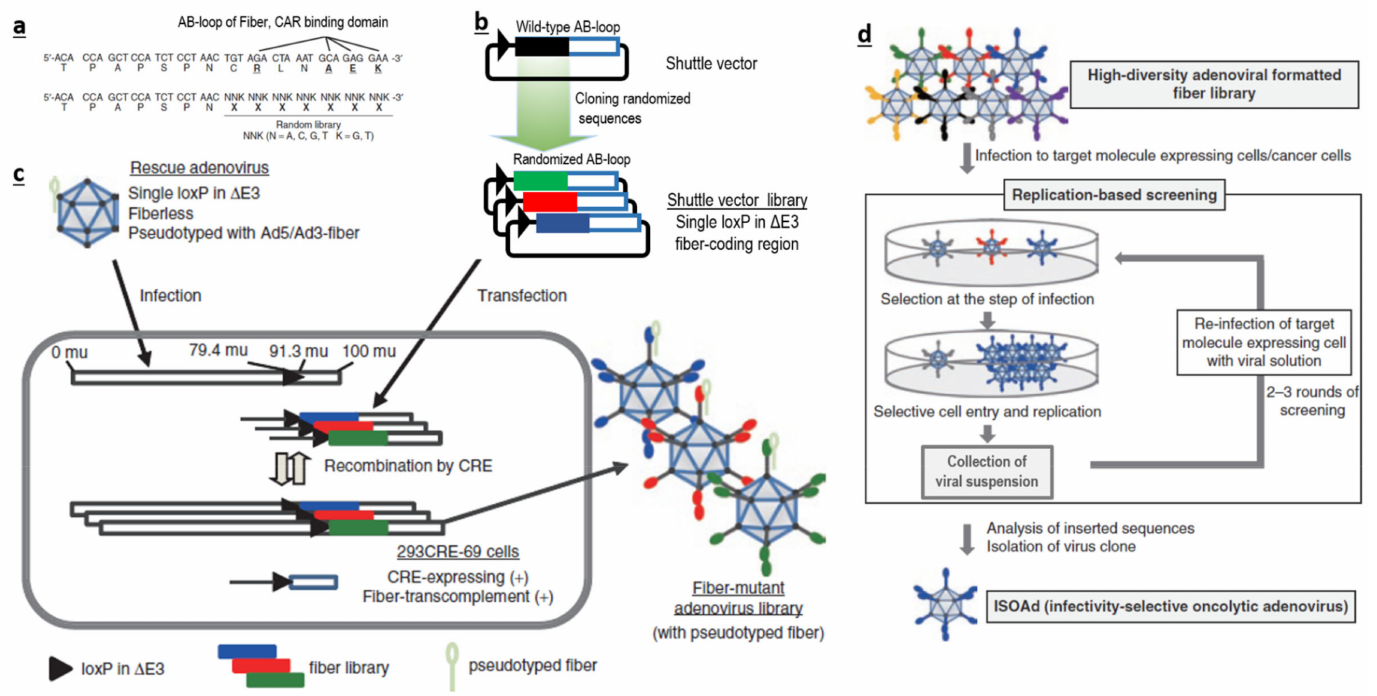
Figure 1. Method used to generate high-sequence diversity libraries and screening: the AB-loop region of the fiber ( a ) was replaced by various sequences, creating a library of shuttle vectors ( b ) and packaging this into functional replicating adenoviruses ( c ). Such libraries can be screened against a target of interest ( d ). Figure adapted from Miura, Y. et al.